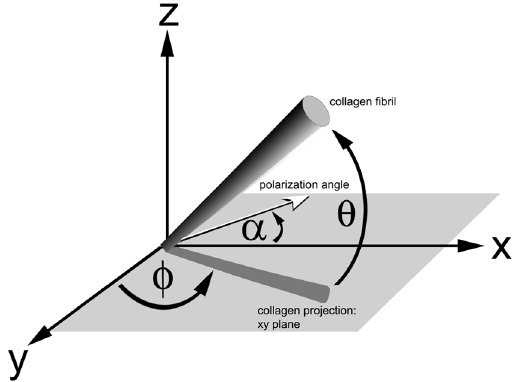
Figure 1. Sketch of collagen fiber orientation in the laboratory frame. The laser beam is incident along the z axis and orthogonal to the xy plane; α refers to the polarization angle of the incident beam with respect to the x axis; φ refers to the angle between the fiber axis in the xy plane and the y axis; θ refers to the angle between the collagen fibril and the xy